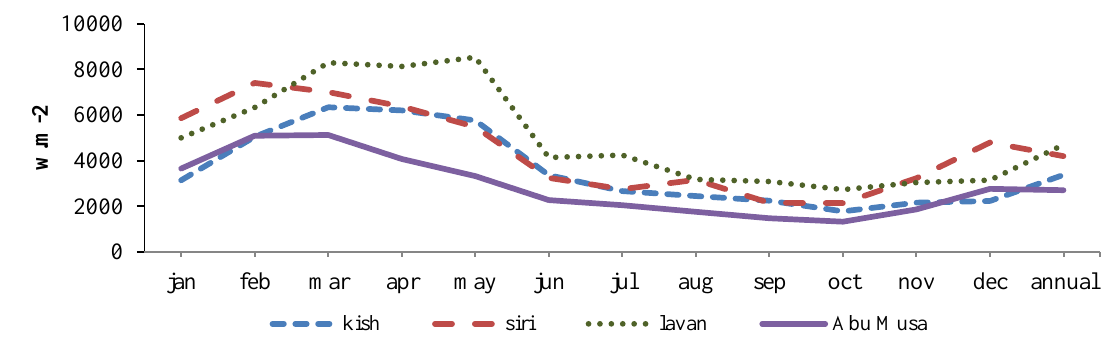
Figure 8. Wind power in islands with 10 m radius rotor